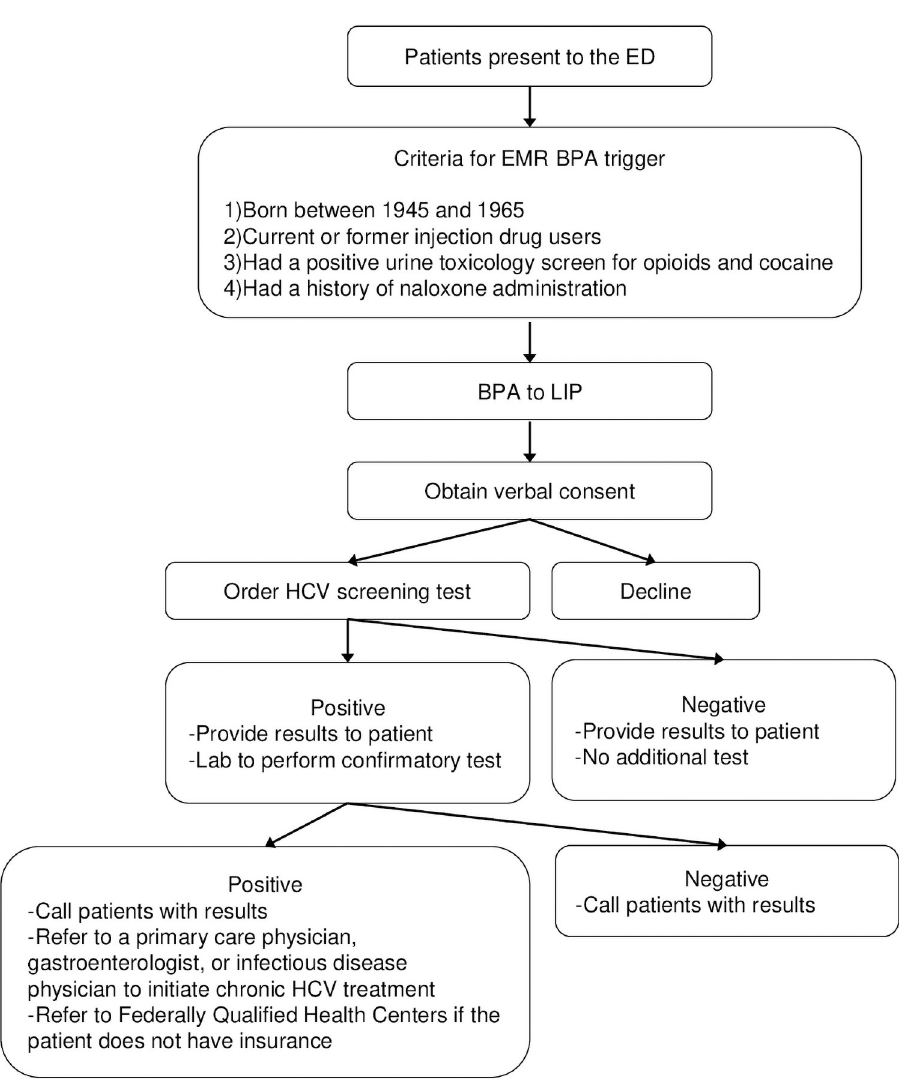
Fig 1. A risk-based HCV screening